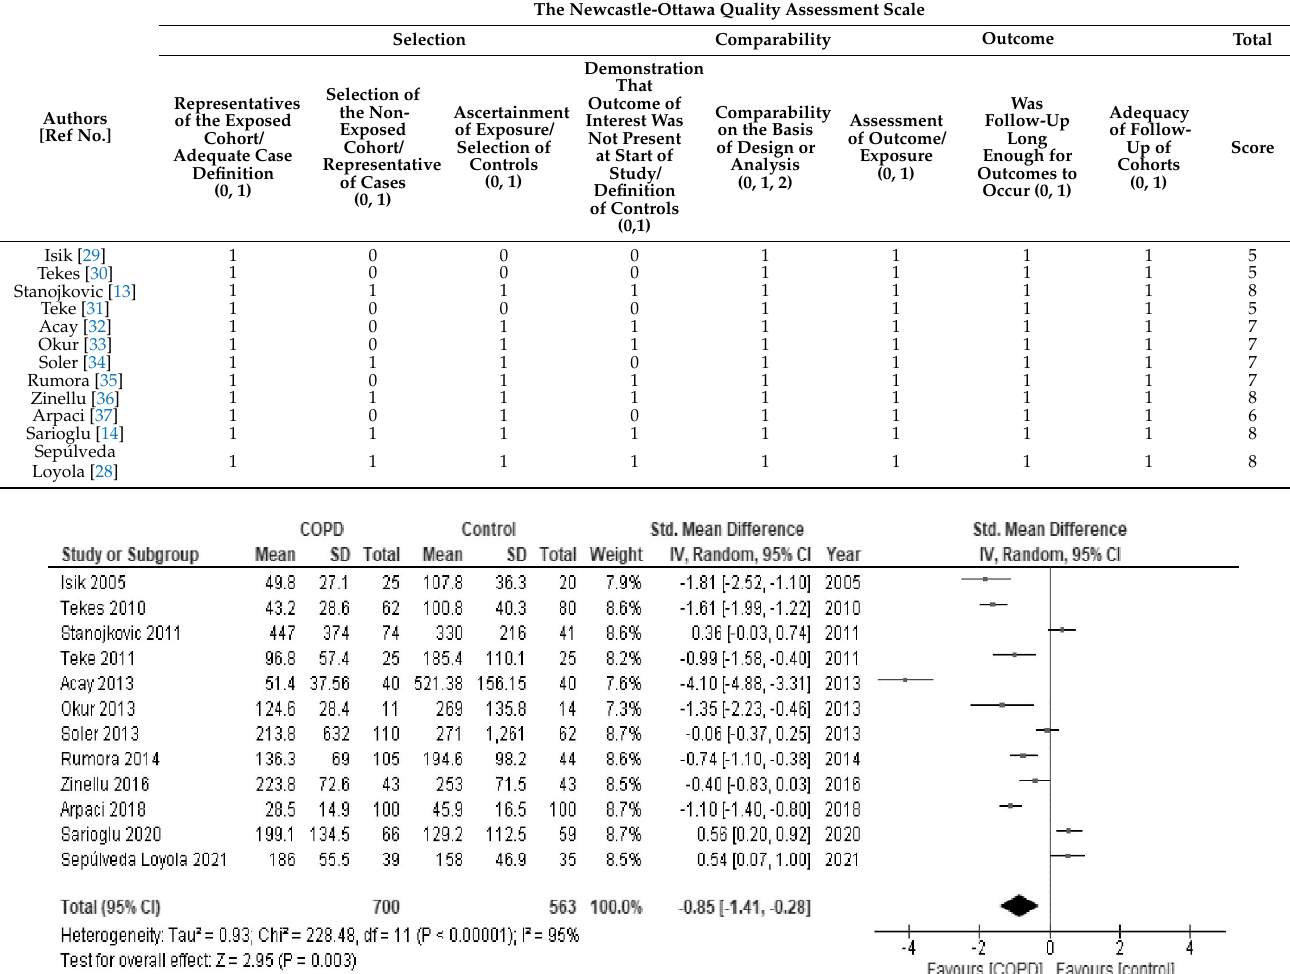
Table 2. Study quality of the included studies.